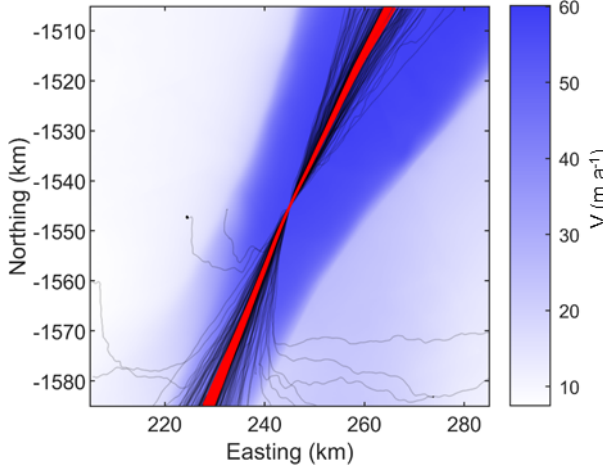
Figure 7. Flow lines through the EastGRIP site (center of plot) cal- culated from the satellite-derived velocity products. The line thick- ness depends on the bias in the product, with thick lines having a small bias and vice versa. The top four products with smallest bias are marked with